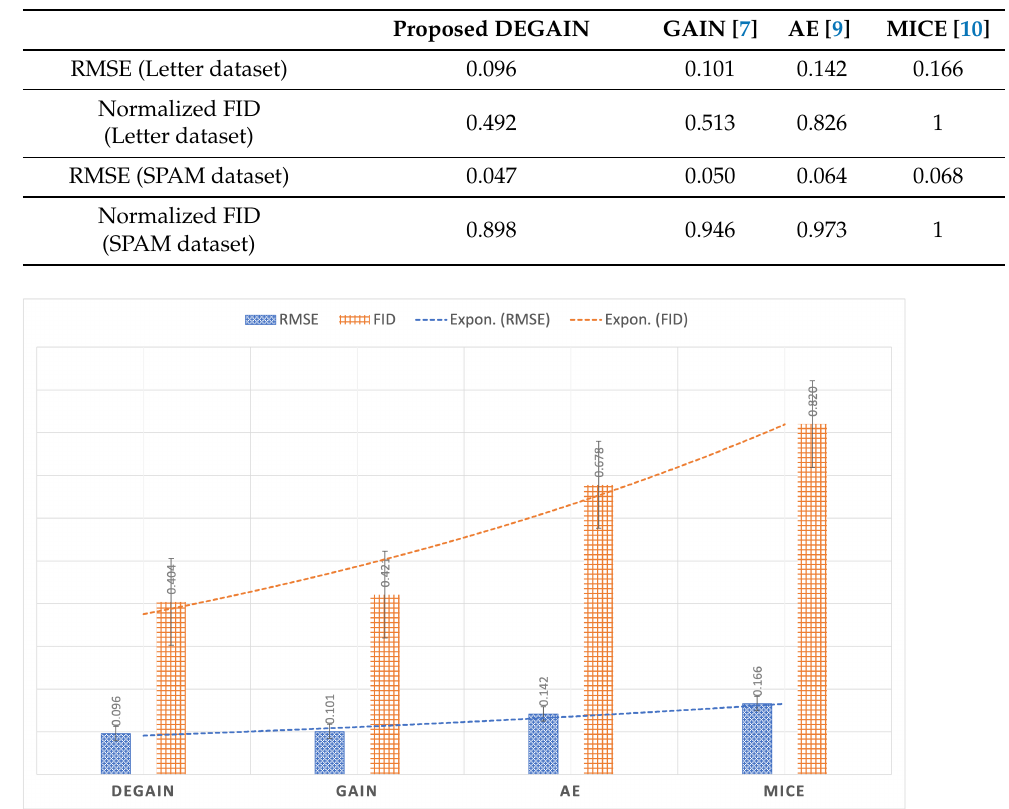
Figure 4. Illustration of evaluation results on RMSE and FID metrics for proposed DEGAIN, GAIN [7], AE [9] and MICE [10] on Letter